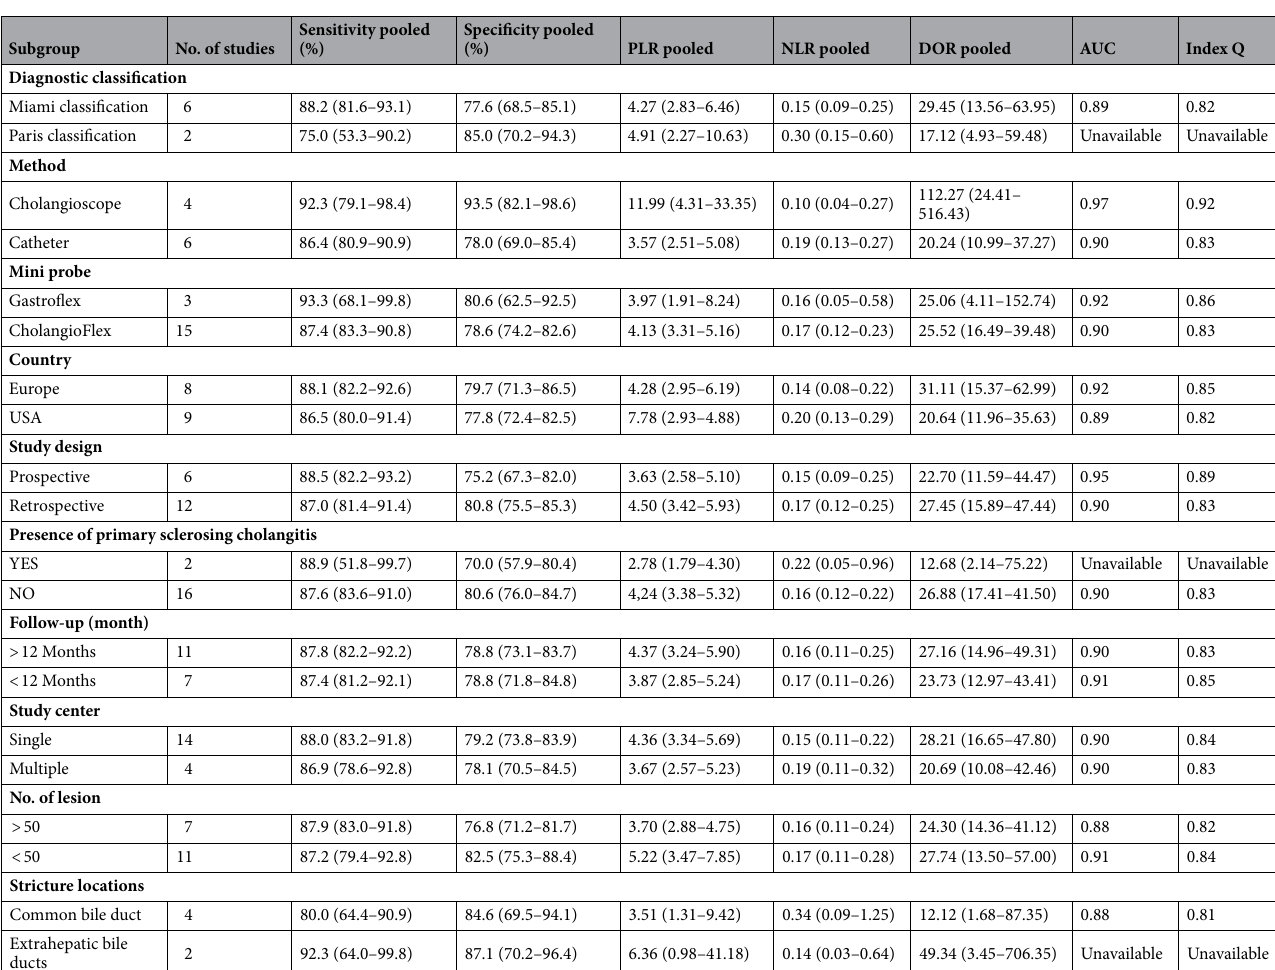
Table 2. Subgroup analysis of diagnostic indices (with 95% confidence